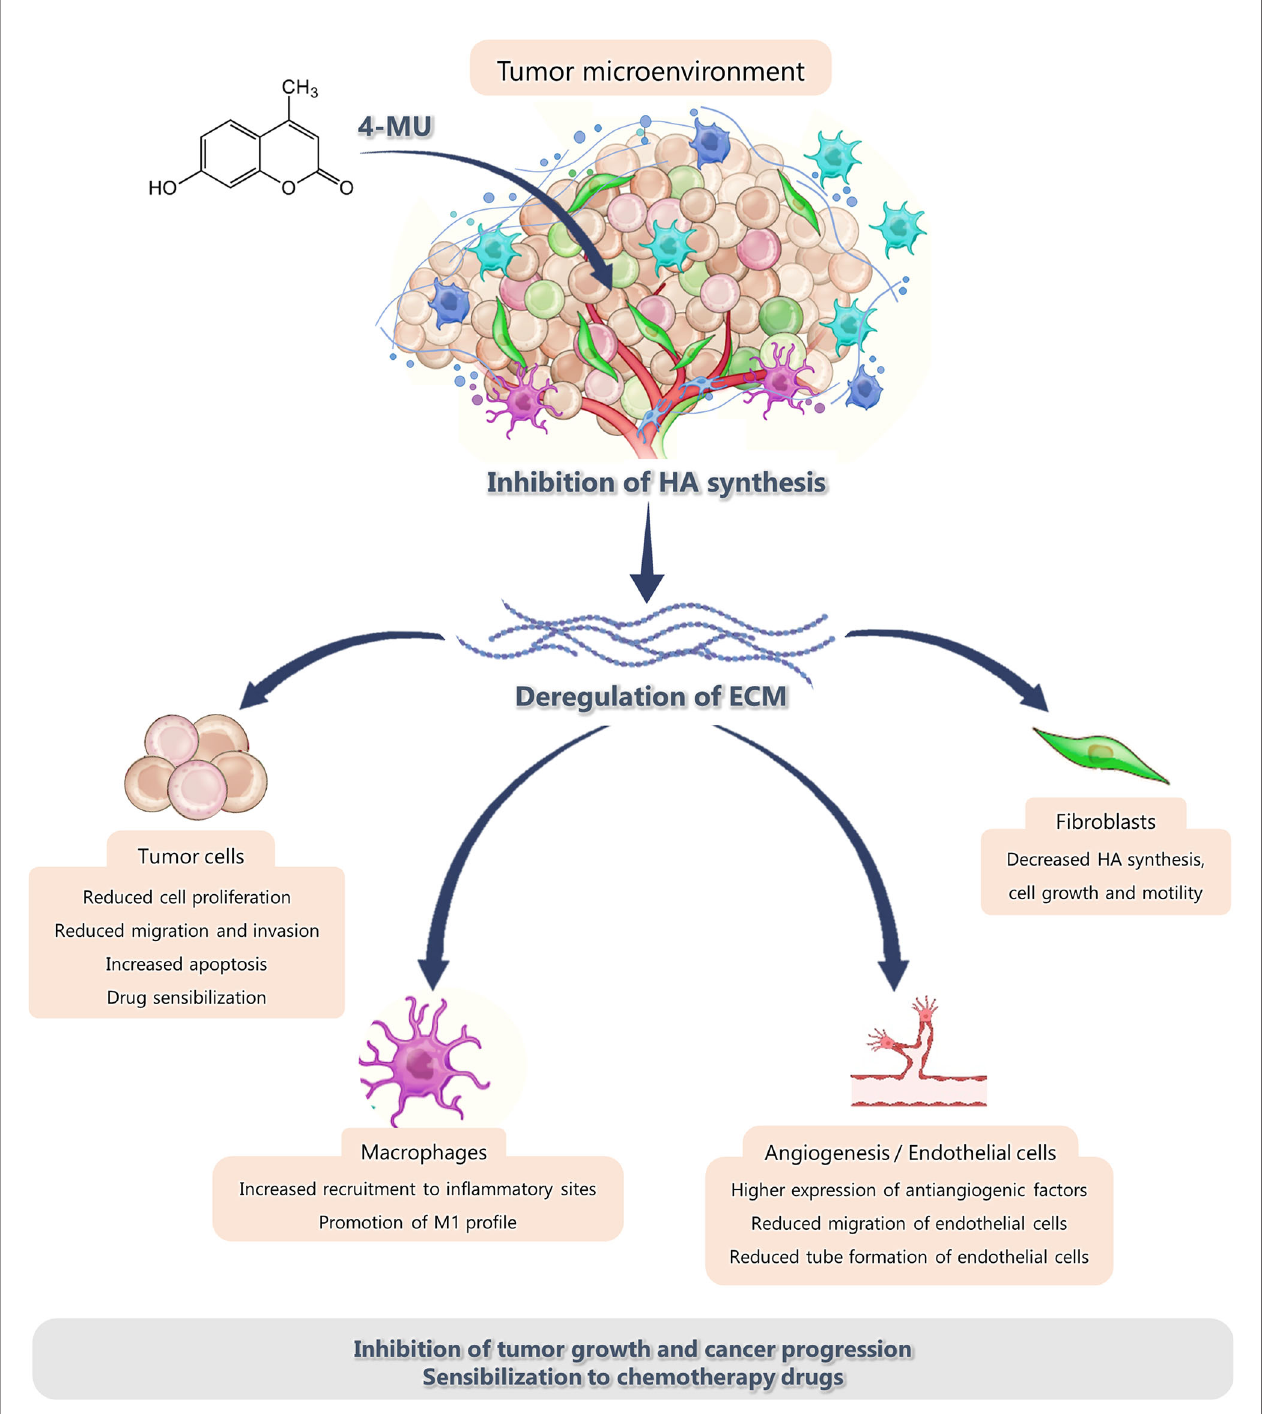
FIGURE 1 | Effect of 4-MU treatment on the components of the tumor